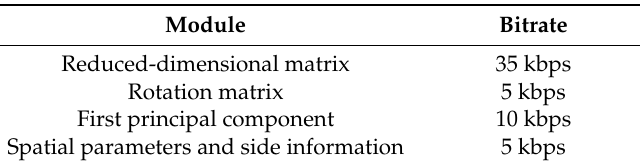
Table 7. Bitrate allocation in encoder.